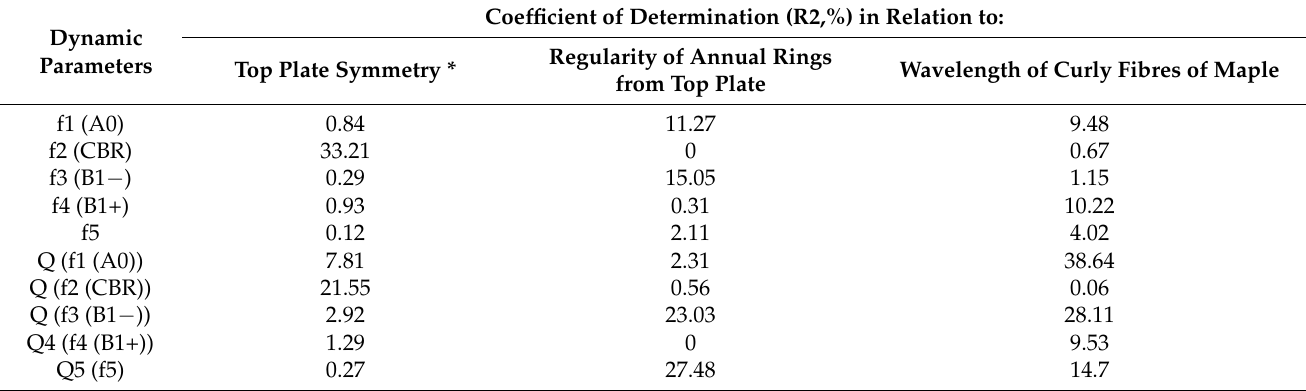
Table 4. Correlation between anatomical structure of wood (from top and back plates) and dynamic parameters. Dynamic